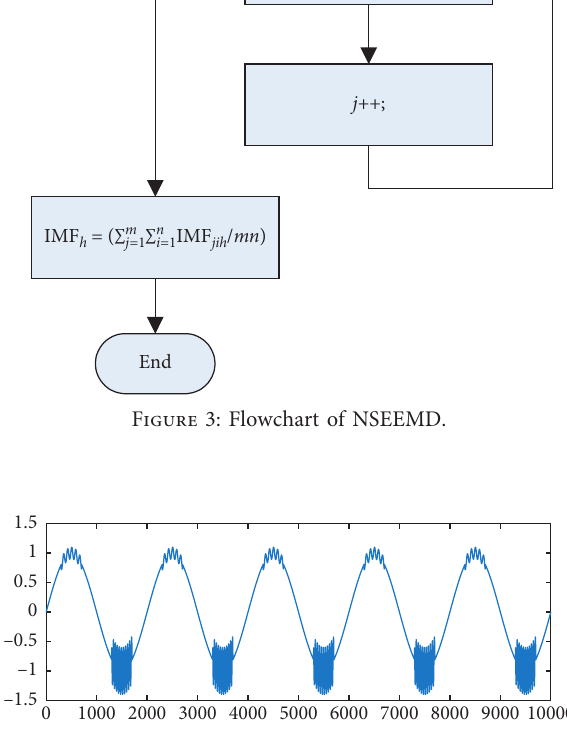
Figure 4: Simulation